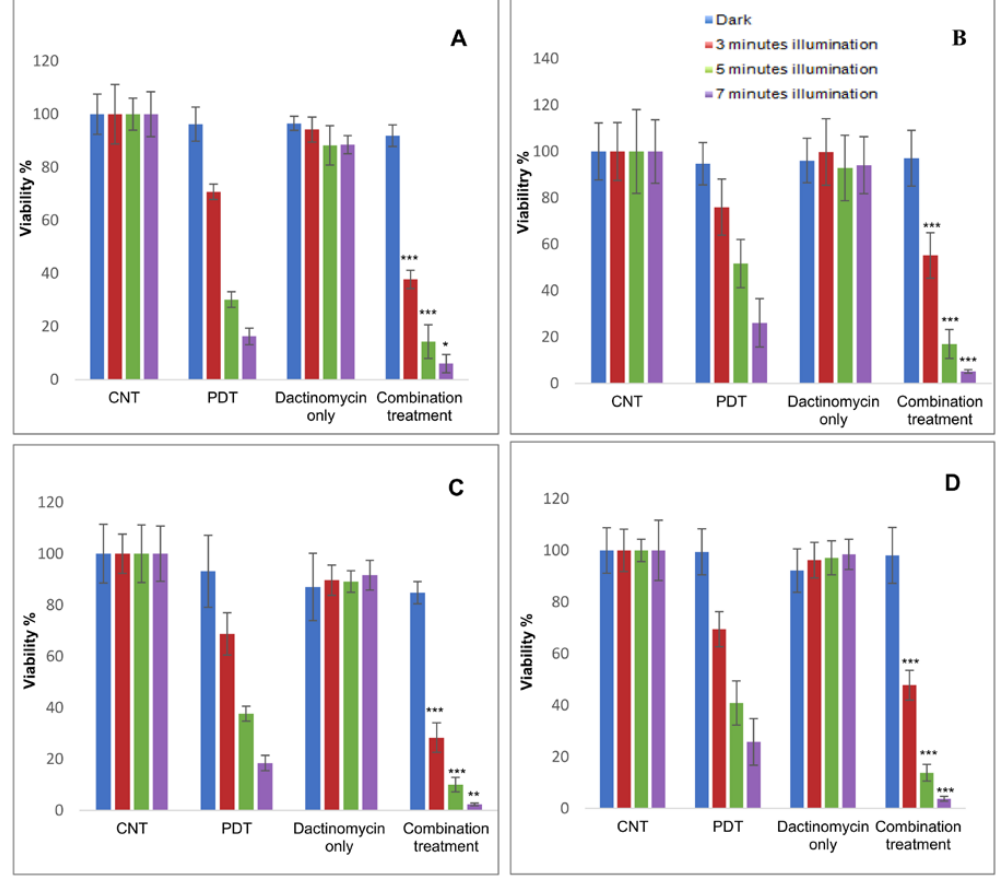
Figure 4. Percentage viability of SKOV3 ( A , B ) and HEY ( C , D ) cells in monolayer cultures after treatment with PDT, dactinomycin and combination treatment using Alamar Blue assay. The cells were treated with TPPS 2a (0.3 µ g / mL for SKOV3 cells, 0.4 µ g / mL for HEY cells), dactinomycin only (1 nM) and combination treatment. The cultures were treated using a blue lamp at wavelength of 420 nM and light power of 7 mW / cm 2 . The total light doses used were 1.26 J / cm 2 (3 min), 2.1 J / cm 2 (5 min) and 2.94 J / cm 2 (7 min). The cultures were incubated for 48 h post illumination before terminating the and D show results obtained from MTT assay. Statistical analysis was carried out using 2-way ANOVA. * p < 0.05, ** p < 0.01, *** p < 0.001. These p values show the significance di ff erence between PDT and combination